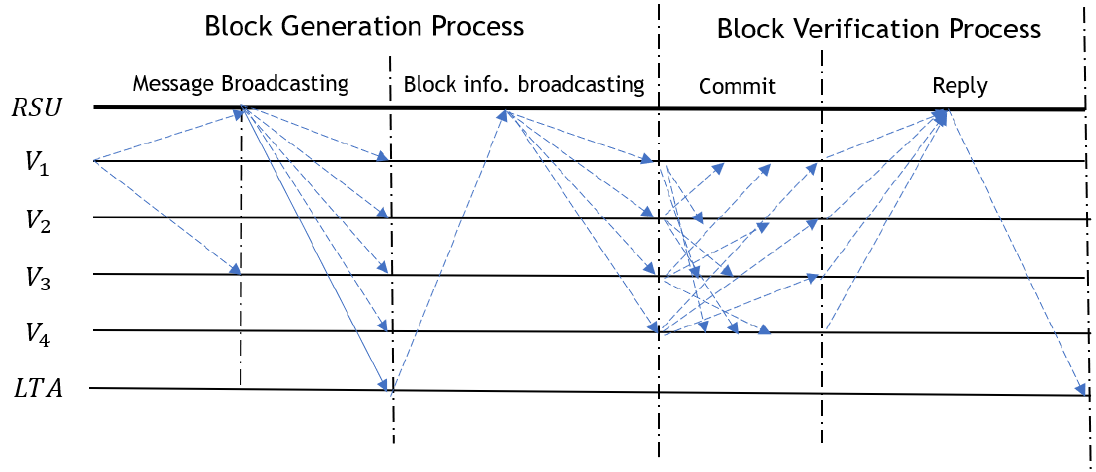
Figure 9. Block generation and verification process.